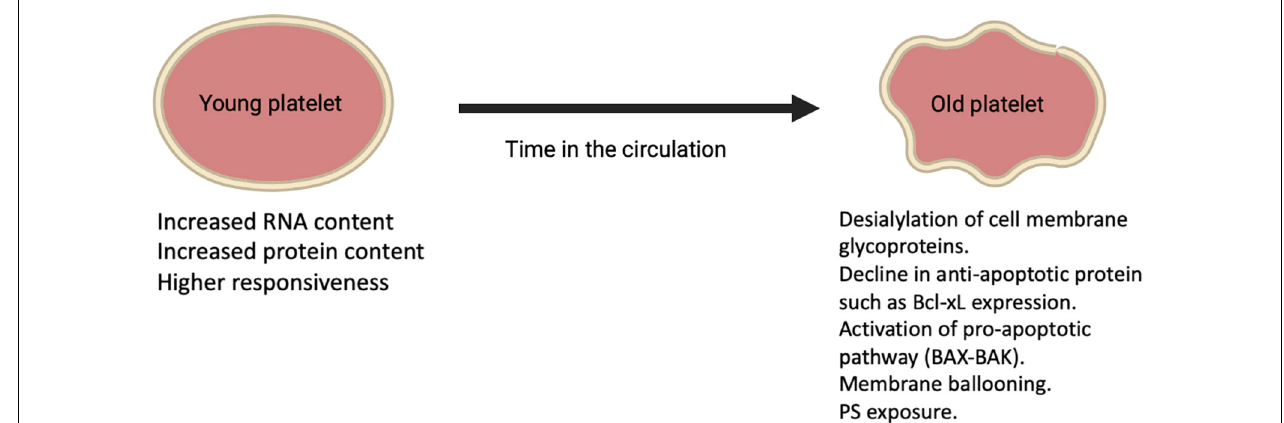
FIGURE 2 | Alterations on platelets during their lifetime in the